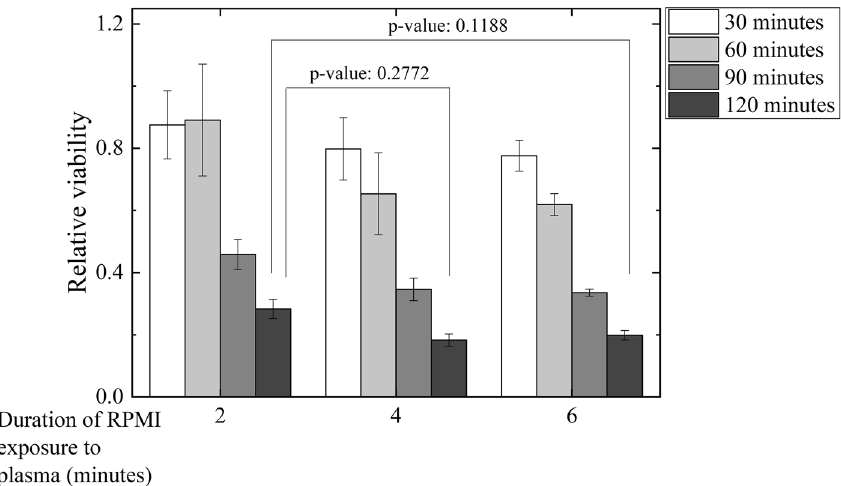
Figure 10. CL1–5 cells were treated with PAM for 30, 60, 90, and 120 min at 37 °C. An MTT assay was performed 1 day after the treatments. RPMI medium was exposed to NTAPPJ for 2, 4, and 6 min to prepare PAM. Data are mean and SD values (n = 3). (Student’s t test).